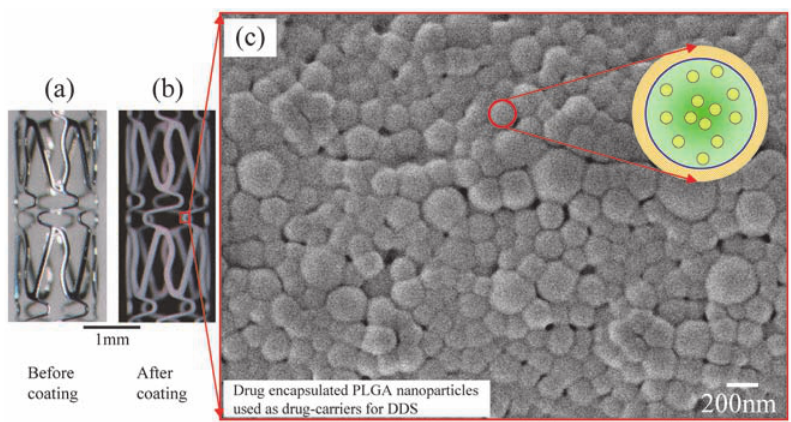
Fig. 1 Optical microscope photographs of a bare metal stent (a) and a drug- eluting stent coated with PLGA nanoparticles (b), SEM image of drug encapsulated PLGA nanoparticles coated onto the stent